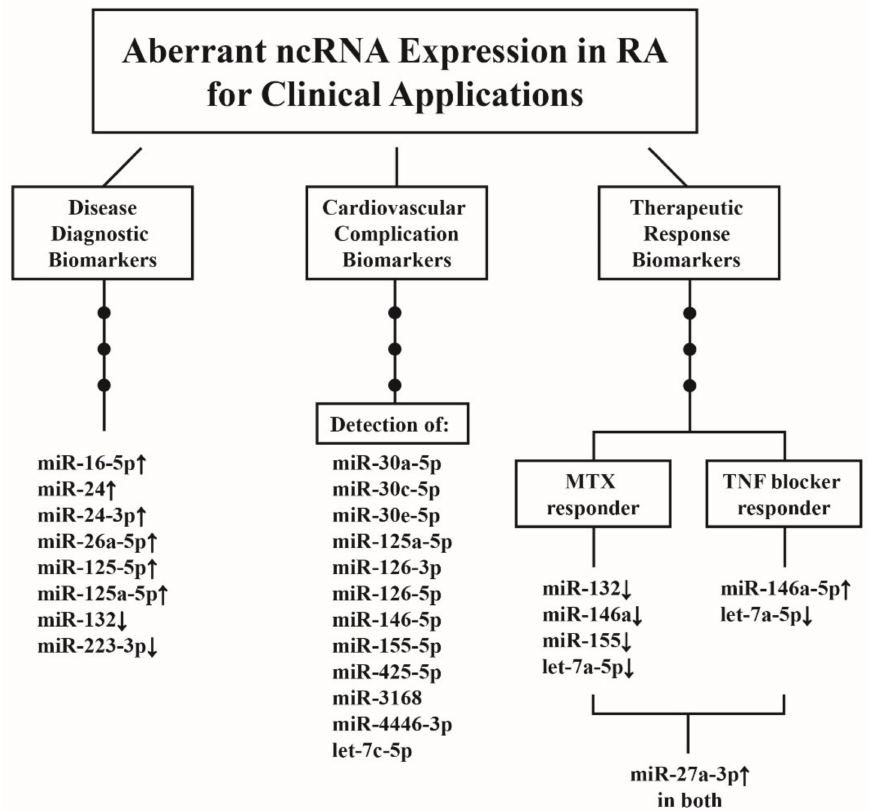
Figure 10. The clinical applications of aberrant ncRNA expressions in patients with RA. These aberrant ncRNA expressions can be used as the biomarkers for disease diagnosis, CV complications, and therapeutic responses. The therapeutic response biomarkers can be further divided into two groups, methotrexate (MTX) responders and TNF- α blocker responders. The increased miR-27a-3p expression is quite unique and can become a biomarker for both groups. ↑ : Increase, and ↓ :